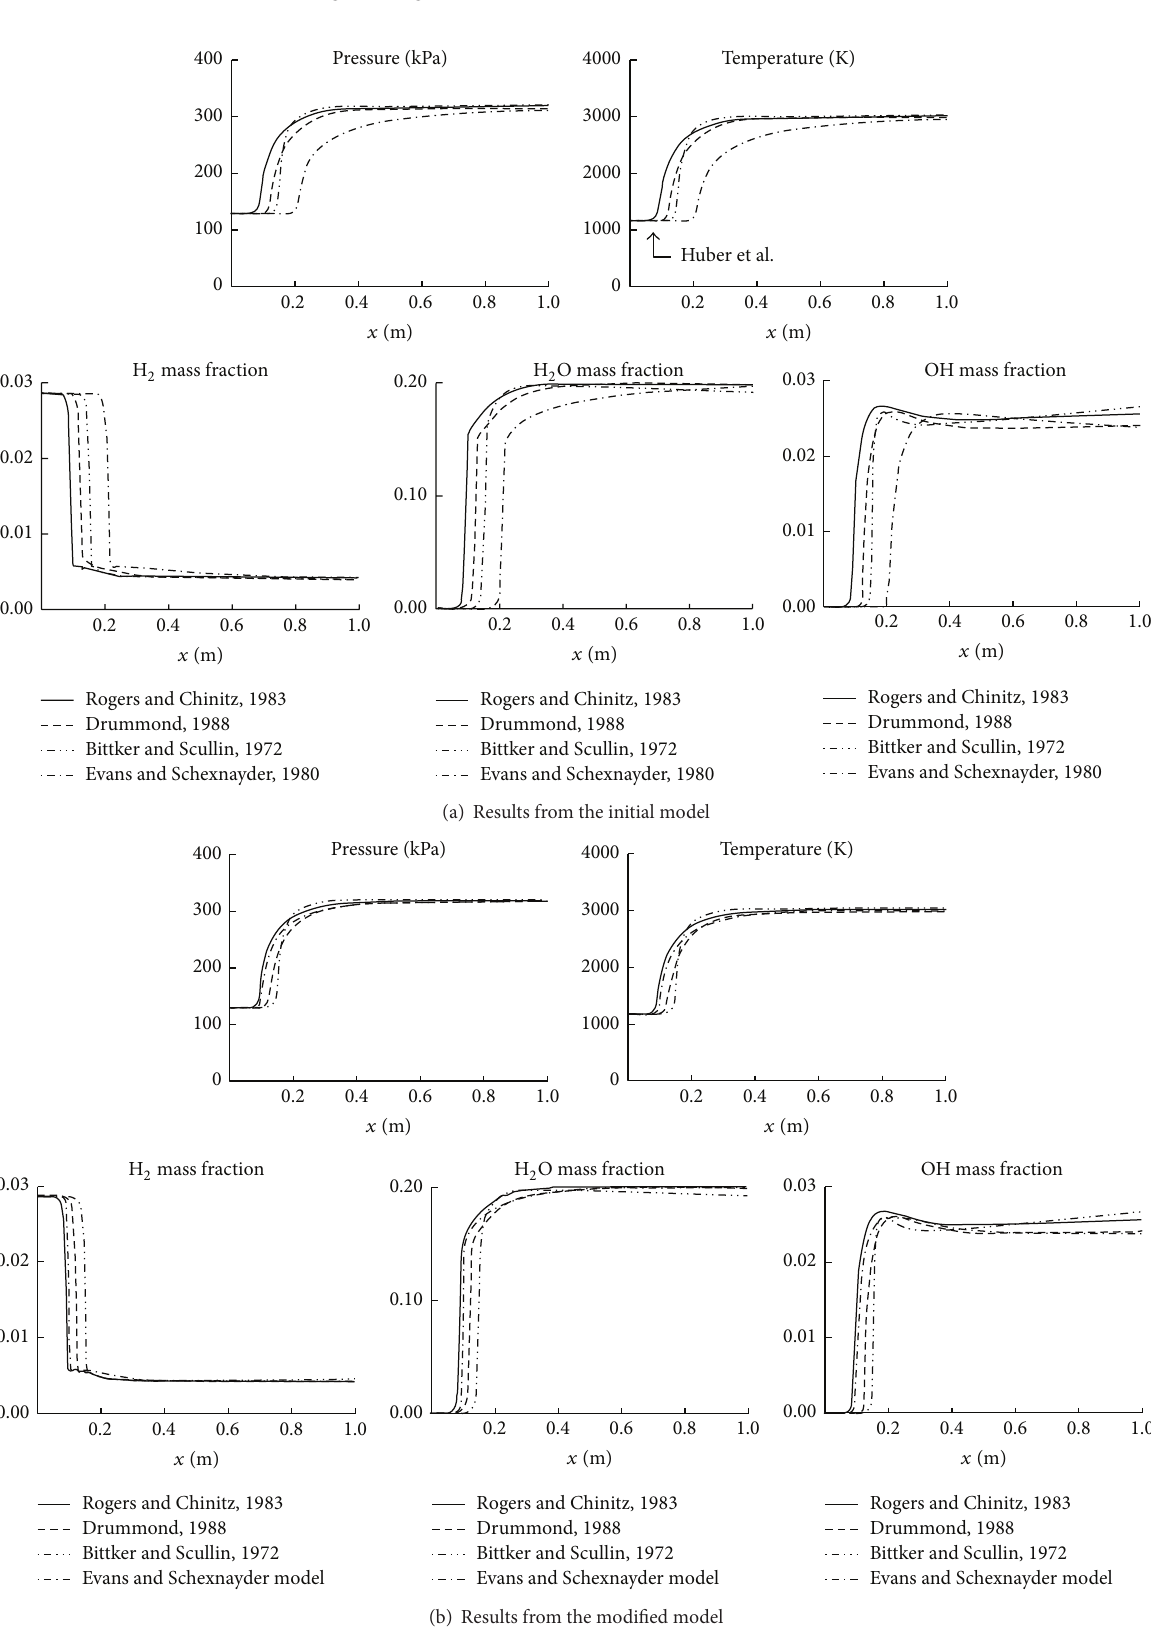
Figure 3: Results of one-dimensional combustion tube simulation obtained with some reaction models compared to initial and modified Evans-Schexnayder reaction model